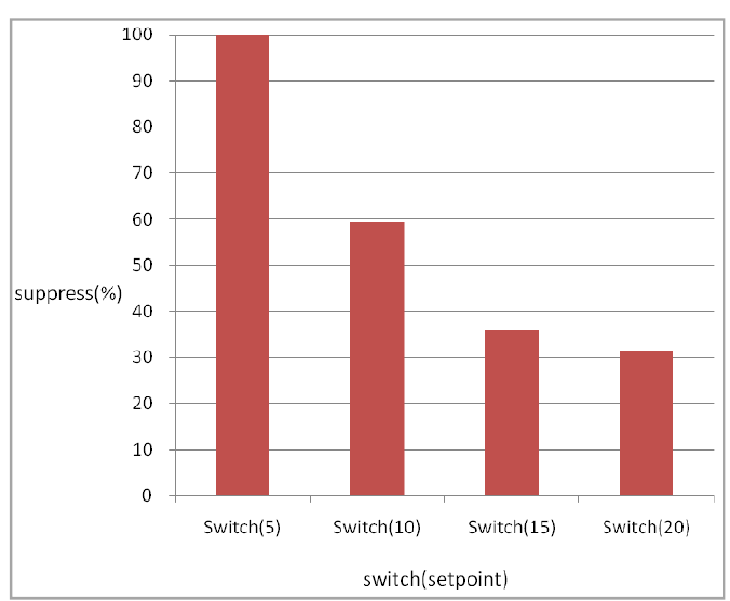
Figure 10. Comparison of switch signal.